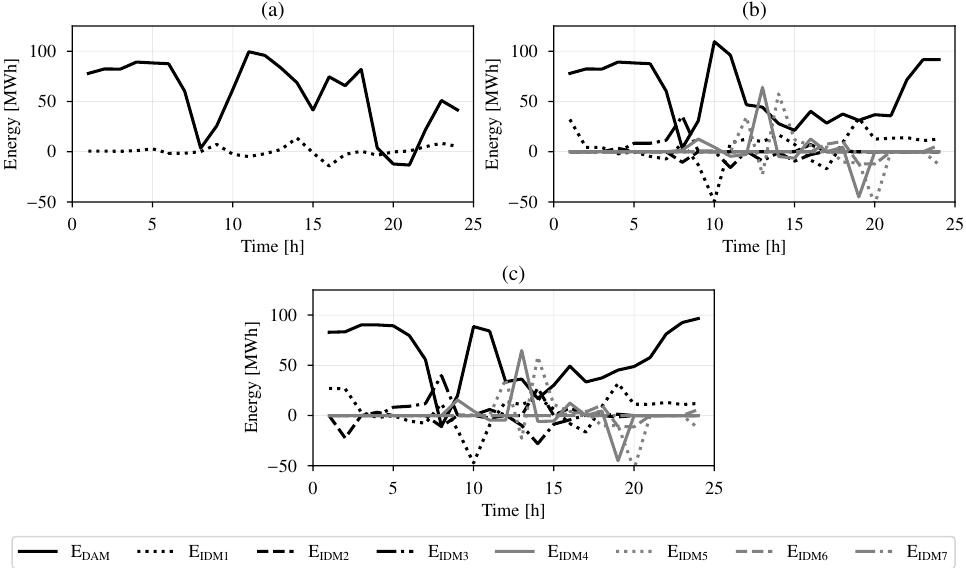
Figure 10. Traded power on a cloudy day at DAM and IDM: ( a ) No Coordination; ( b ) VPP with default load profile; ( c ) VPP with three load profiles at zero